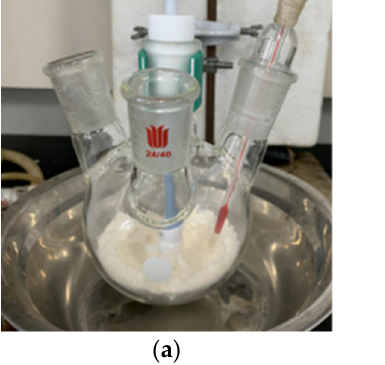
( c ) Figure 3. Sulfonation synthesis process 2. ( a ) Temperature rise to 110 °C for reaction; ( b ) after the reaction; ( c ) washed and filtered finished products.